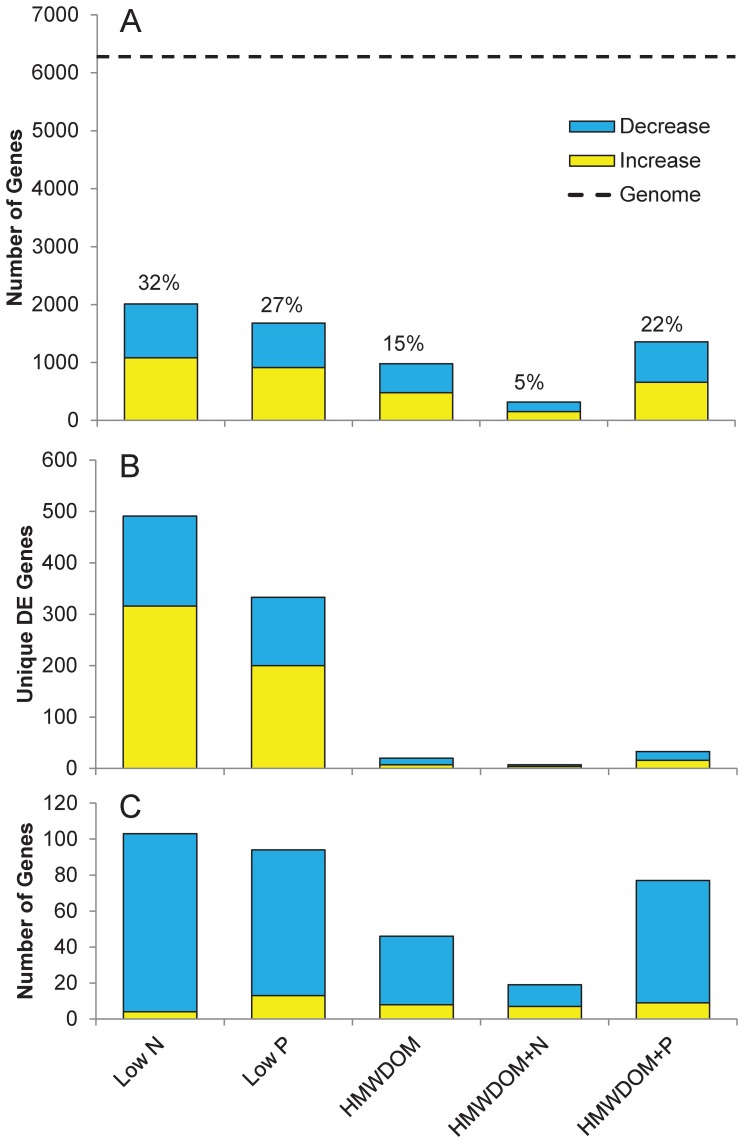
Gene expression results.A) Number of differentially expressed genes for each treatment as compared to the number of protein encoding genes in the Microcystis aeruginosa NIES-843 genome (dotted line) with the percent of the genome that was differentially expressed appearing above the bars. B) The number of differentially expressed (DE) genes that were unique to each treatment and C) the number of genes differentially expressed within the photosystem and respiration functional category within each treatment. Increases in transcript abundance are in yellow whereas decreases in transcript abundance are in blue. All differentially expressed genes were significant to p≤0.05.